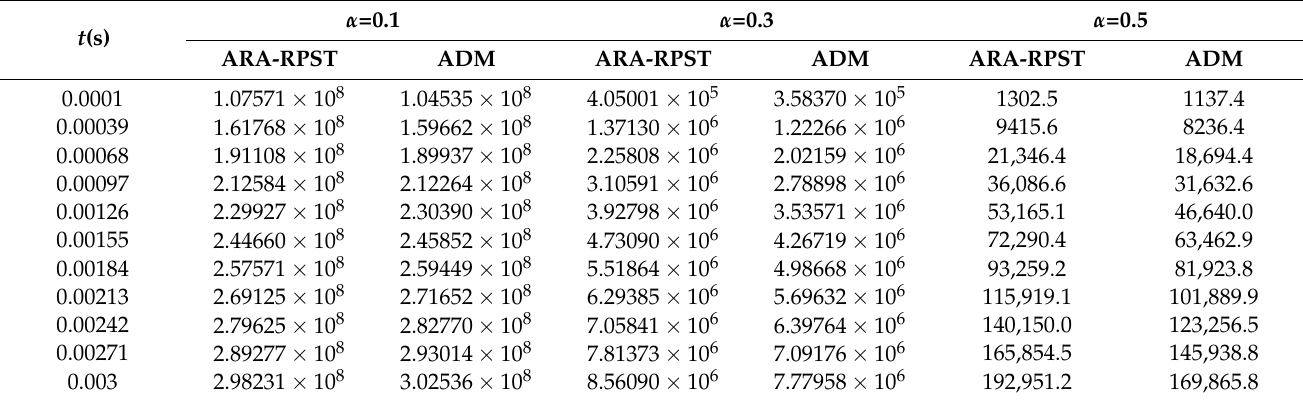
Table 1. Numerical results of neutron flux at different values of α , z 0 ( x ) = 1.